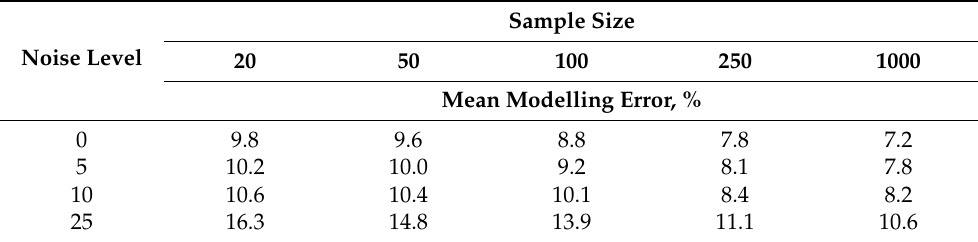
Table 3. Results of the study of nonparametric models with a random value of smoothing factors on the test set.